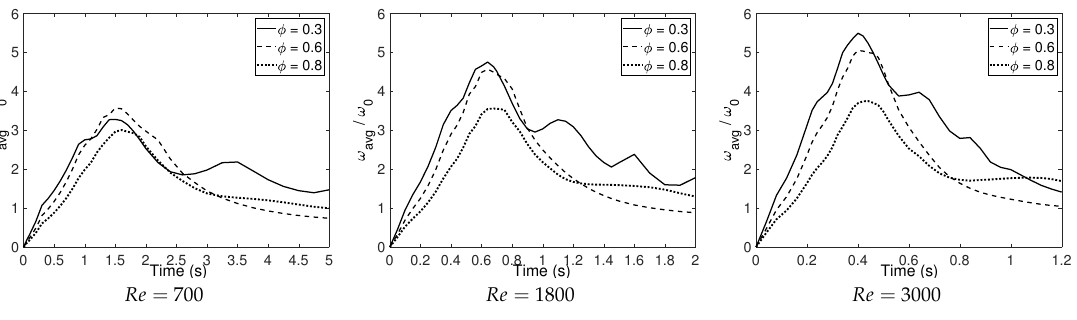
Figure 12. Average vorticity in computational domain within t ∗ = 45.